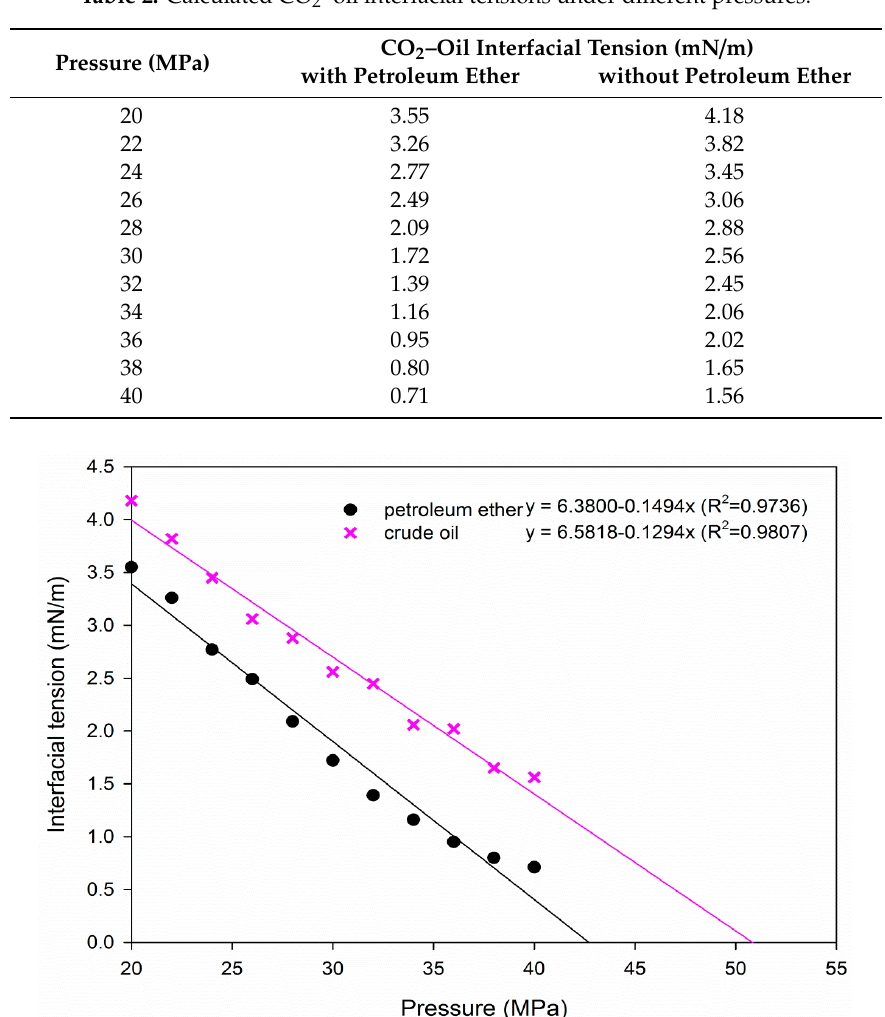
Figure 4. Changes of CO 2 –oil interfacial tensions with pressures for diluted crude oil with petroleum ether and undiluted crude oil.